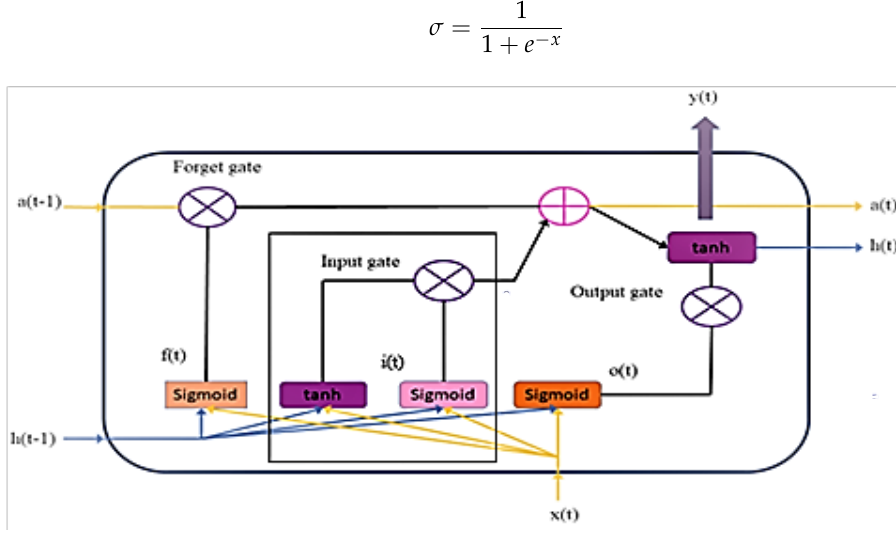
Table 1. Range of the hyperparameters used in proposed model.